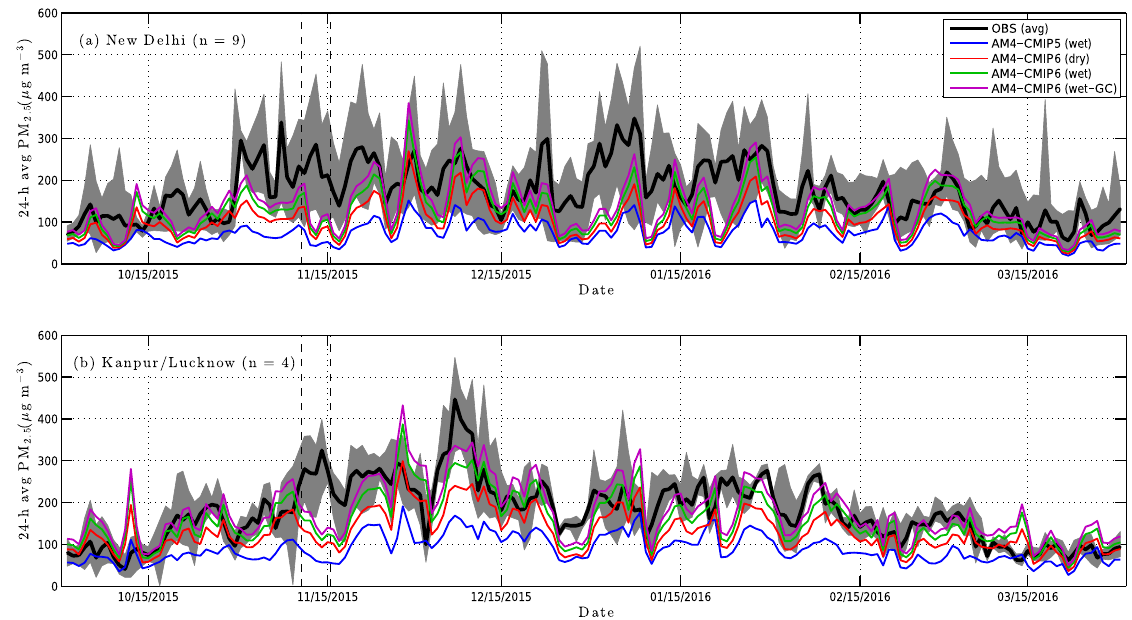
Figure 2. Time series of daily average PM 2 . 5 (1 October 2015–31 March 2016) for the grid cells over (a) New Delhi and (b) Kan- pur/Lucknow, Uttar Pradesh. The min-to-max range of the multiple observations sites are shown in grey with their median in black. The number of sites is given in the panel titles. Modeled abundances are shown in (blue) CMIP5-wet, (red) CMIP6-dry, (green) CMIP6-wet, and (magenta) CMIP6-wet calculated with the GEOS-CHEM hygroscopic growth factors. The dashed vertical lines represent the 5-day festival of